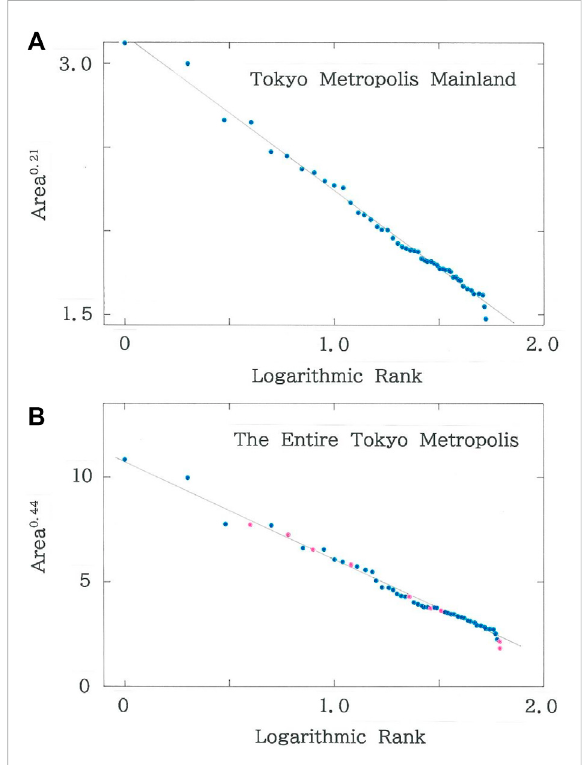
FIGURE 3 (A) Dependence of the areas (km 2 ) of municipalities in the mainland of the Metropolis of Tokyo on the logarithmic rank. The brown declining line indicates the optimized fi t (| r | = 0.9961 with d = 1.861 for q = 0.21 and n = 53; a = 3.16, b = 0.919) [8]. (B) Dependence of the areas (km 2 ) of municipalities in the entire Metropolis of Tokyo on the logarithmic rank. The brown line indicates the optimized fi t (| r | = 0.9936 with d = 1.267 for q = 0.44 and n = 62; a = 10.8, b = 4.67). Data of municipalities on the territorial islands are highlighted with pink